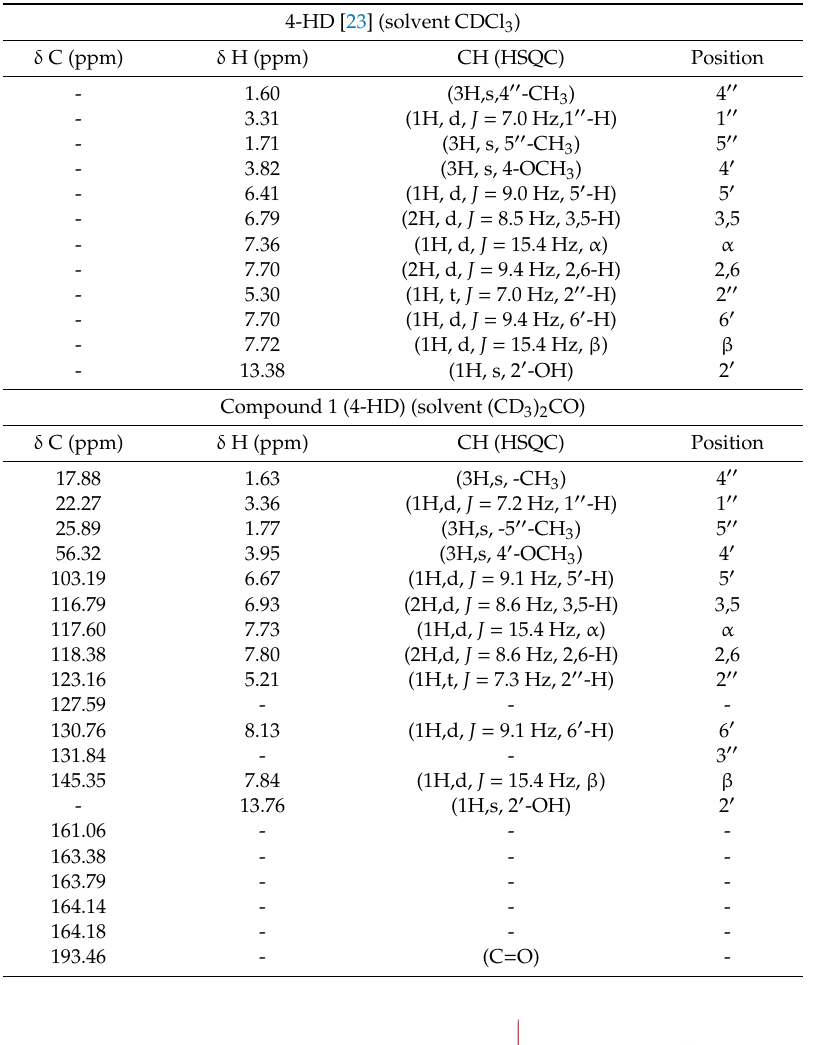
Table 1. 1 H and 13 C NMR data of 4-hydroxyderricin from A. keiskei .